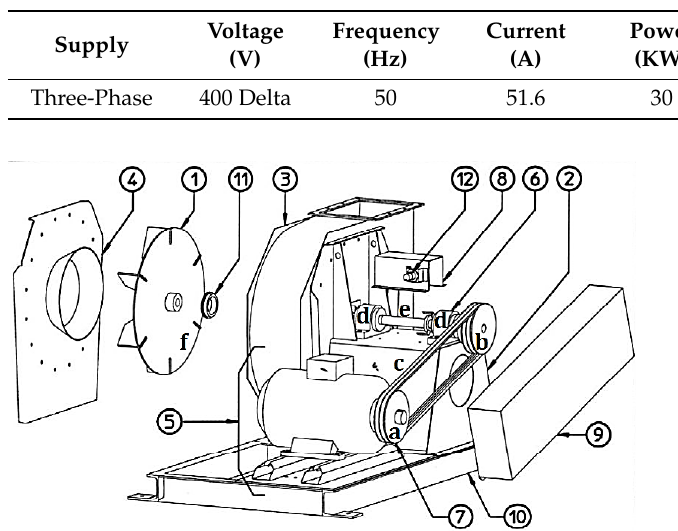
Figure 3. The physical system with